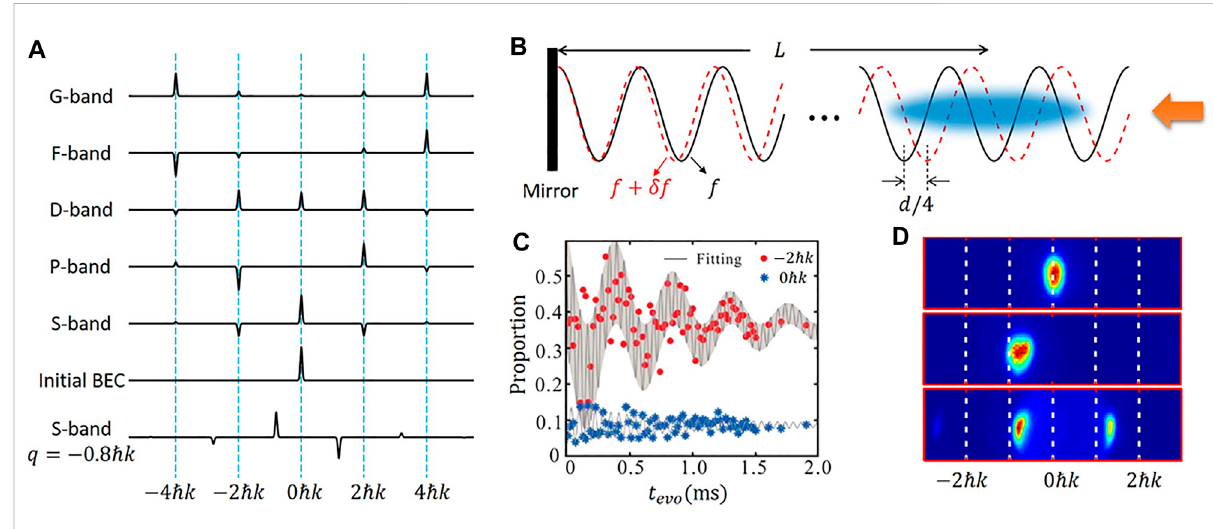
FIGURE 4 (A) Fromthebottomtothetop,thesolidlinesrepresentthemomentumdistributionsofdifferentstates(S-bandwith q = − 0.8 Z k ,initialBECwith p = 0, S-, P-, D-, F-, and G-band with zero quasi-momentum). (B) Two 1D lattices with a d /4 position shift. (C) Population oscillations around momenta − 2 Z k (red points) and 0 Z k (blue stars). The solid lines are the fi tting curves. (D) The experimental images: from top to bottom, the images are for the initial BEC with p = 0, the BECs with p 0 = − 0.8 Z k after acceleration, and the fi nal states Ψ 1, − 0.8 Z k